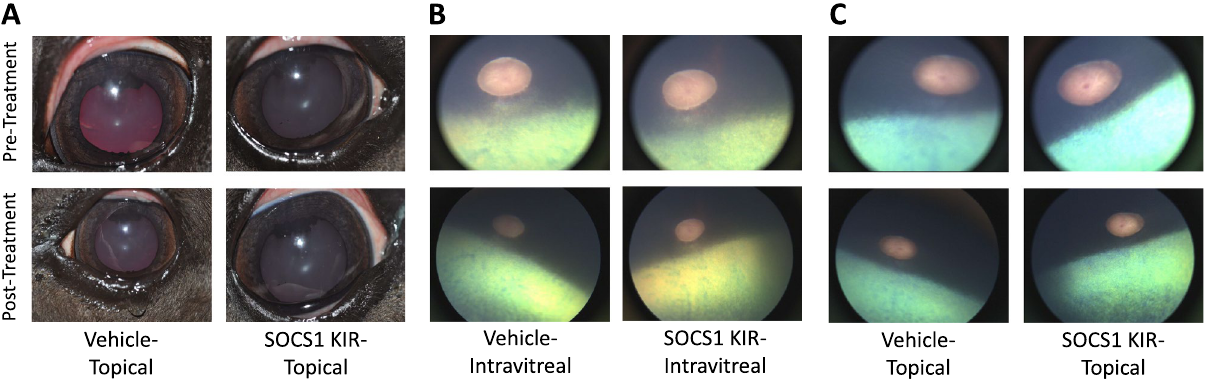
Figure 3. SOCS1 KIR Treatment Is Safe for the Equine Eye. Representative before and after photograph ( A ) and Fundus ( B ) images of equine eyes treated with either vehicle or topical SOCS1 KIR for 14